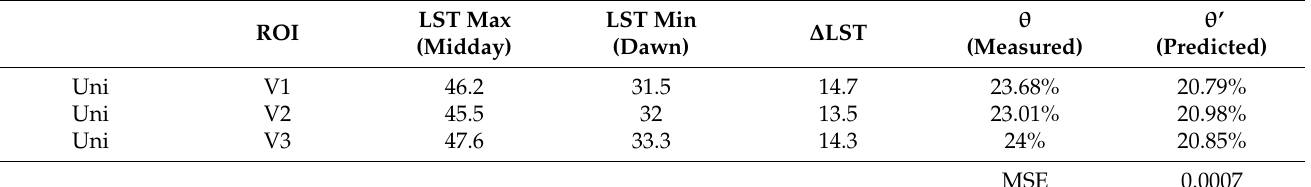
Table 12. ∆ LST vs. soil moisture regression model validation